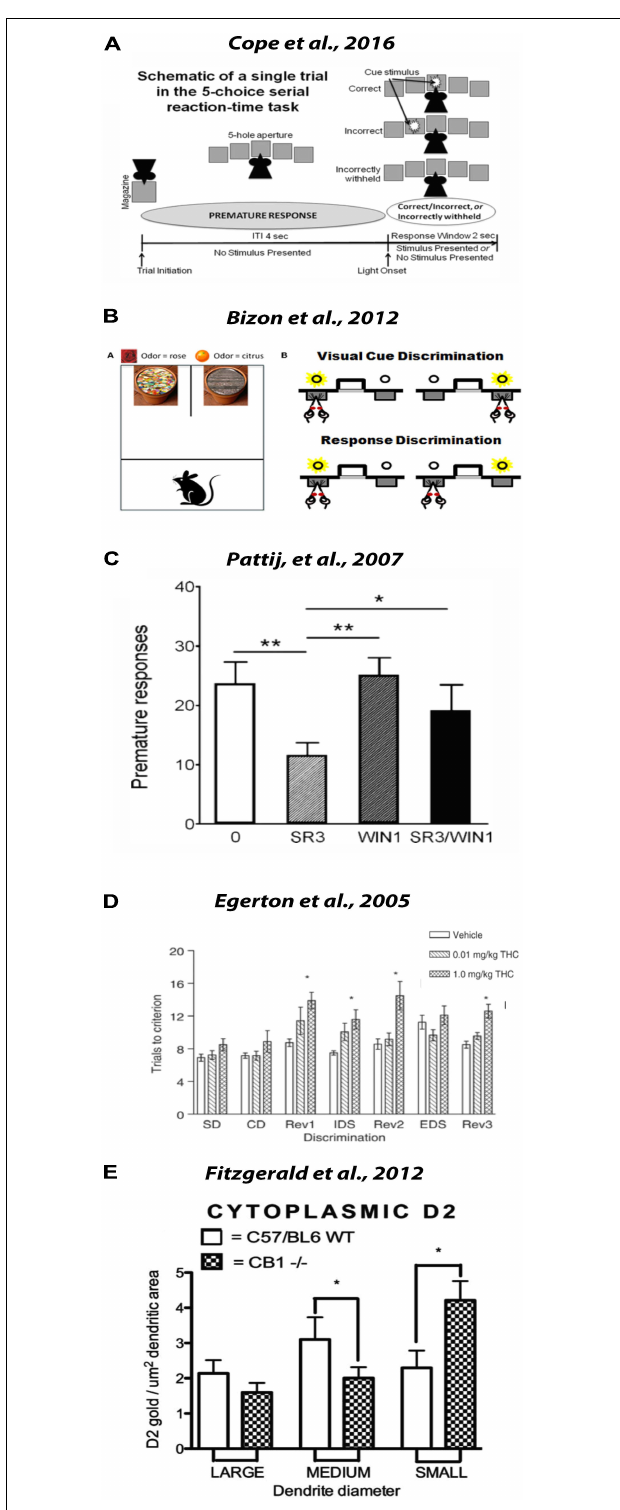
FIGURE 7 | Cannabinoids modulate attentional processes. (A) Schematic of a single trial in the 5-choice serial reaction time task (5-CSRTT). Animals are trained to perform a nose poke when one of five cue lights is presented in any